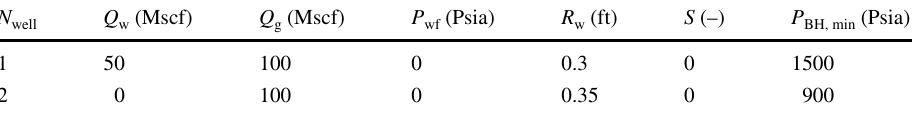
Table 12 Well input data